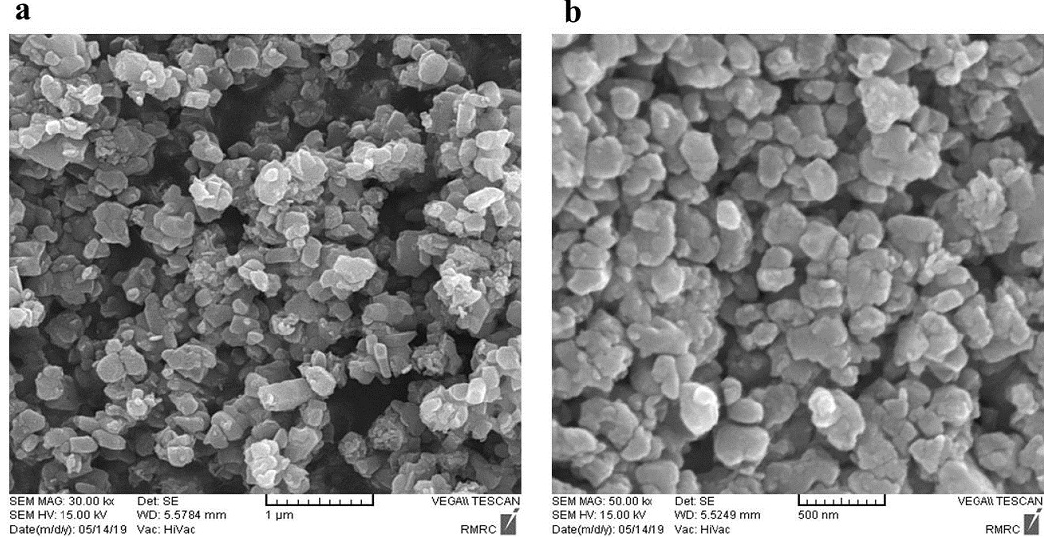
Figure 3. [Bi(HQ)(Cl) 4 ] n SEM scans at various magnifications. ( a ) 1 μm and ( b ) 500 nm.